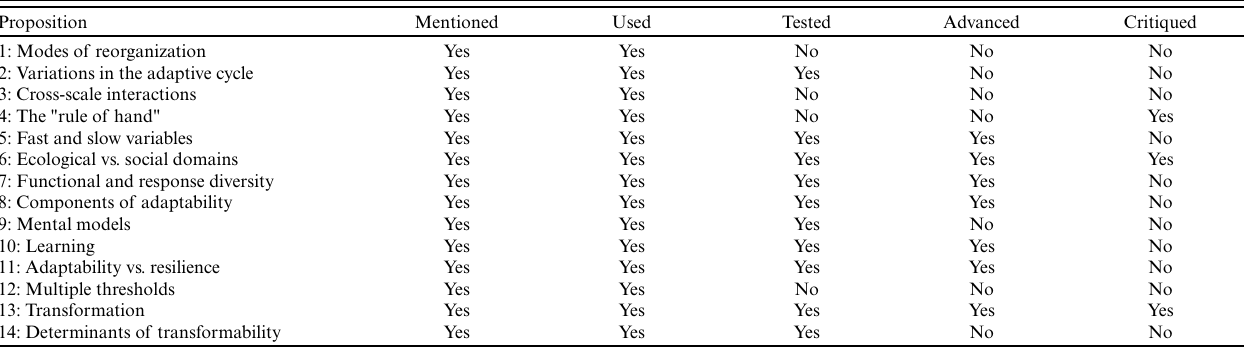
Table 3. Proposition engagement. Propositions were placed into categories depending on the level of engagement with that proposition in the scientific literature. “Mentioned” – referred to by citing articles, “Used” – used to justify claims or methods, “Tested” – proposition examined through theoretical models and/or case studies to assess utility or applicability, “Advanced” – proposition was substantially advanced through theoretical models and/or case studies, “Critiqued” – citing articles critical of the propositions’ utility or validity.